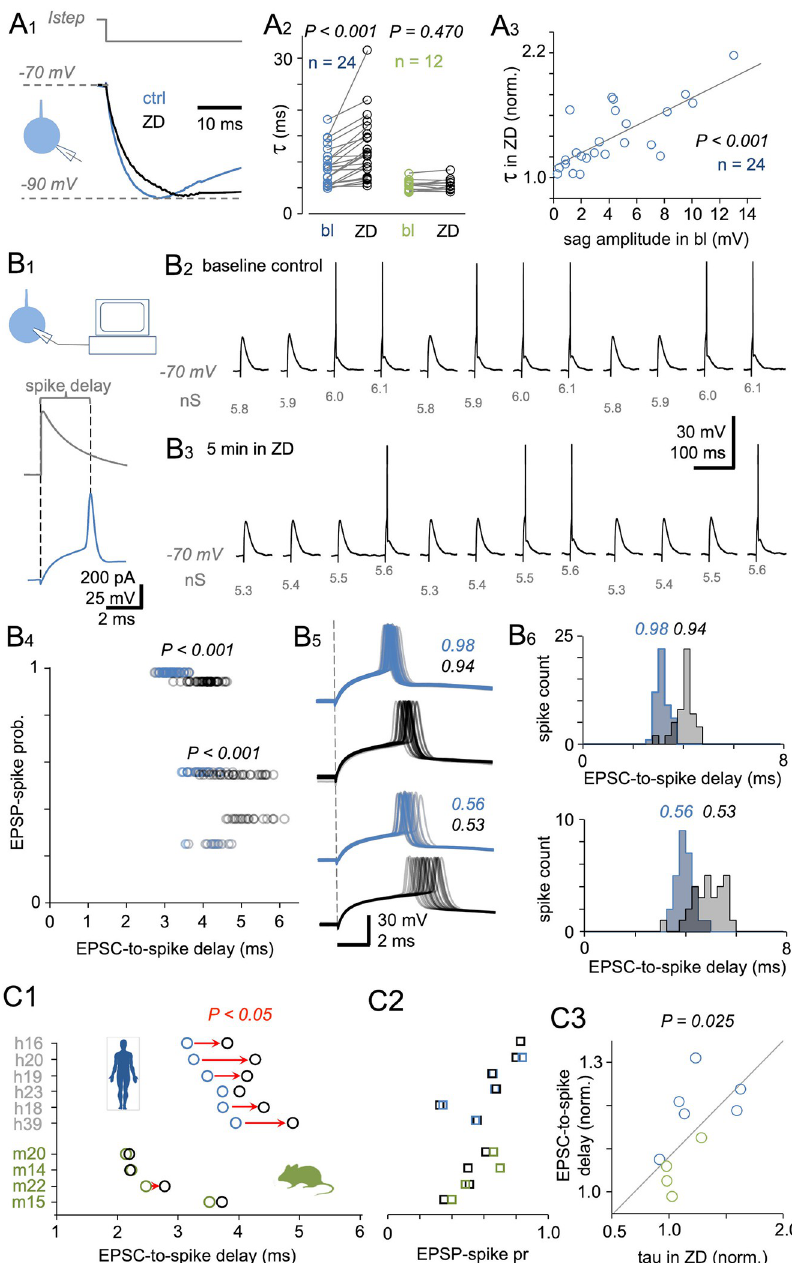
Fig 5. HCN channel blockade lengthens the somatic time constant and somatic spike generation delay in human fast-spiking interneurons. ( A ) The HCN channel blocker ZD7288 slows the time course of membrane potential changes in human fast-spiking interneuron soma. ( A1 ) Somatic membrane apparent time constant ( τ ) measured from equal-amplitude hyperpolarizing membrane potential steps from − 70 mV to − 90 mV in whole-cell clamp mode (illustrated in inset schematic) under control conditions (blue, average of five traces from one cell) and in the presence of ZD7288 (black). Istep shows time course of the hyperpolarizing square-pulse current step. ( A2 ) Plot summarizing τ as measured using standard hyperpolarizing membrane potential steps for human and mouse fast-spiking cells (A1) at baseline control (bl) and following ZD7288 (ZD) infusion. τ is significantly lengthened by ZD in human (blue, P < 0.001, n = 24 cells) but not mouse (green) fast-spiking cells ( n = 12, P = 0.470 by Wilcoxon signed-rank test). ( A3 ) The effect of ZD7288 on somatic membrane τ is strongest in cells showing the largest HCN sag potential amplitude at baseline. Plot shows the baseline-normalized membrane τ value in the presence of ZD (ordinate) against the sag amplitude (abscissa) measured before ZD wash-in. The two parameters show a strong correlation ( n = 24, R = 0.73, P < 0.001 by Spearman’s rank order correlation analysis). Gray line shows regression. ( B ) ZD prolongs the